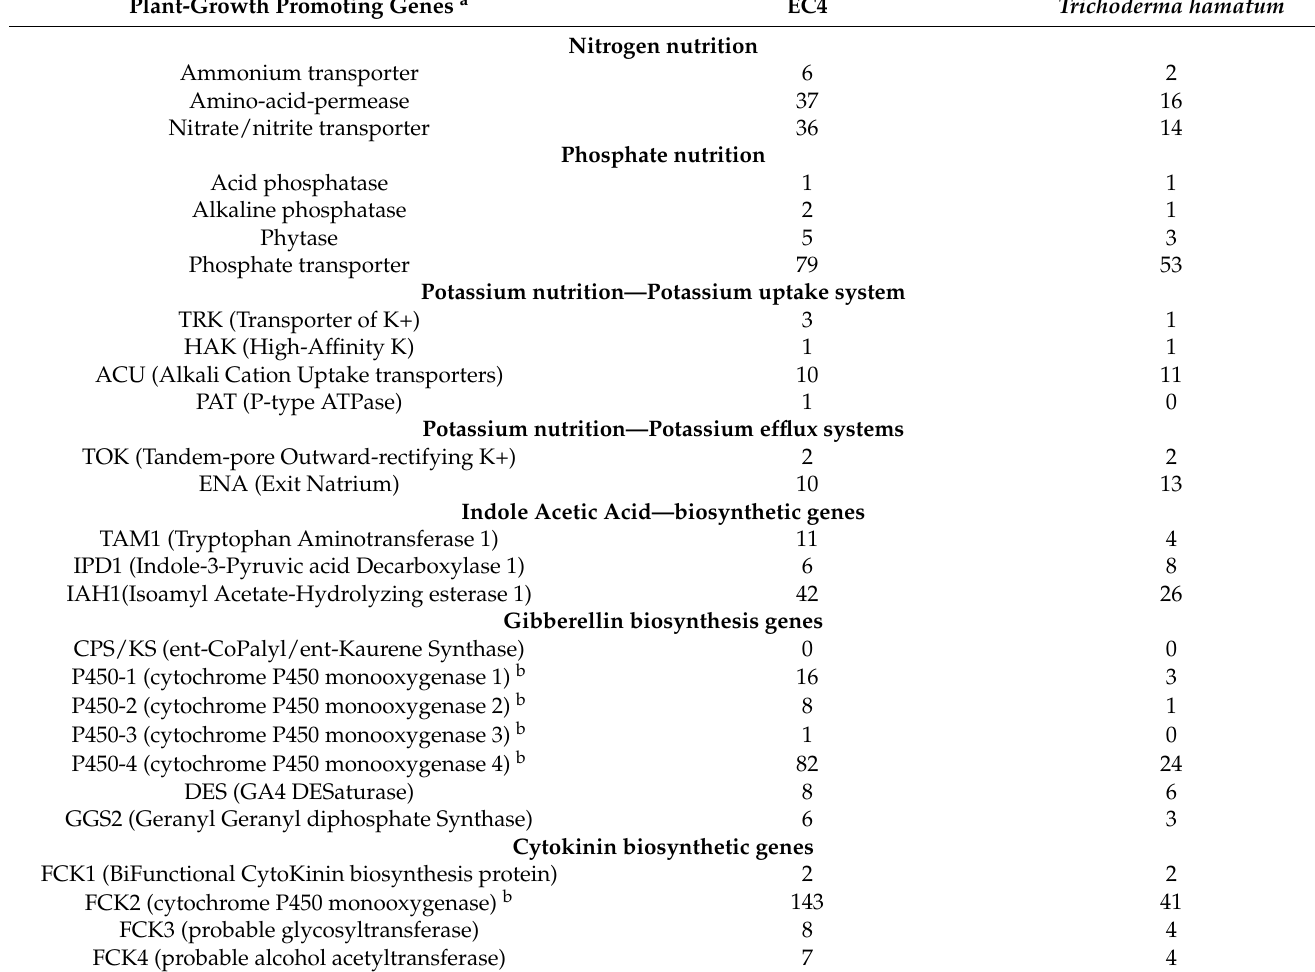
Table 2. Gene families identified in EC4 and Trichoderma hamatum with the potential to promote plant